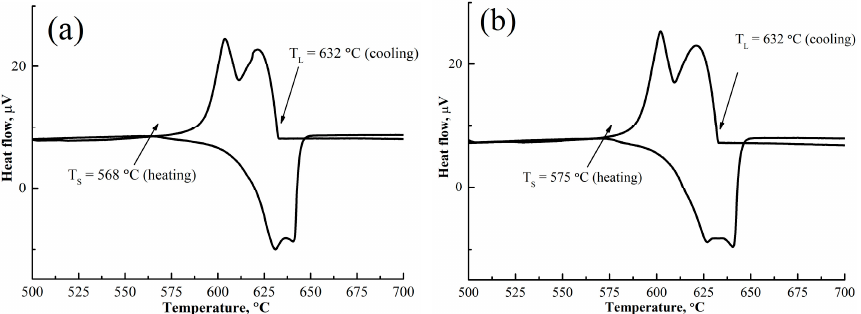
Figure 3. DSC curves of the ( a ) AlCuYbMg and ( b ) AlCuGdMg alloys .